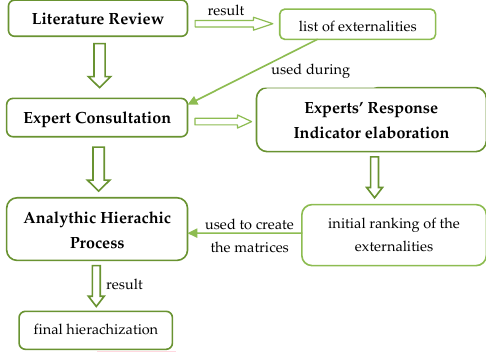
Figure 3. Methodological phases.